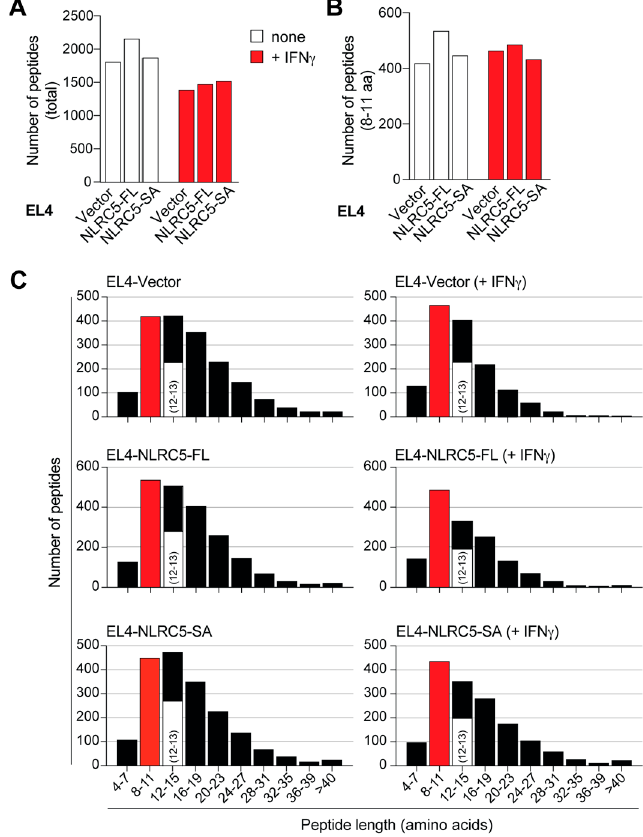
Figure 4. MHC-I-associated peptide repertoire of NLRC5-expressing EL4 cells. ( A ) MAPs were eluted from EL4 cells expressing empty vector, NLRC5-FL or NLRC5-SA, stimulated or not with 20 ng/mL IFN γ for 24 h. The eluted MAPs were identified by the PEAKS software to include peptides from known protein database as well as de novo peptides. Number of all MAPs and 8–11 amino acid long MAPs are shown in ( A , B ), and the peptide size distribution in ( C ). The number of 12–13aa long peptides are indicated within the 12–15aa long MAPs. The lists of 8–13aa long peptides from all samples are given in Supplementary Table S2.